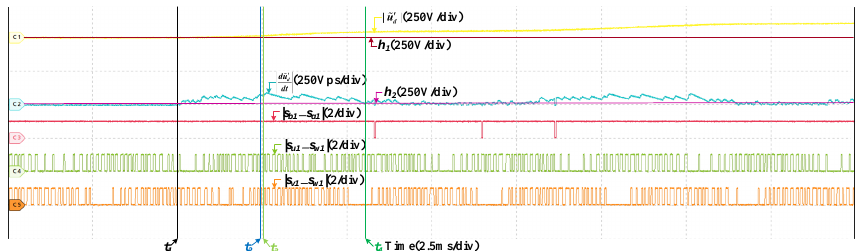
Figure 12. HIL results when the scaling fault occurs in S Cn at 200 km/h.